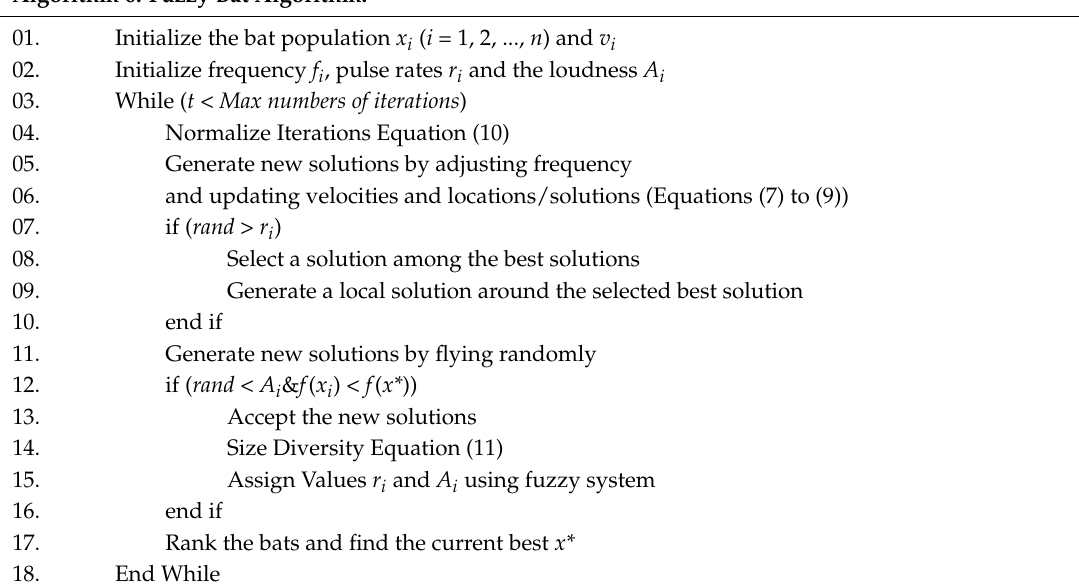
Algorithm 6. Fuzzy Bat